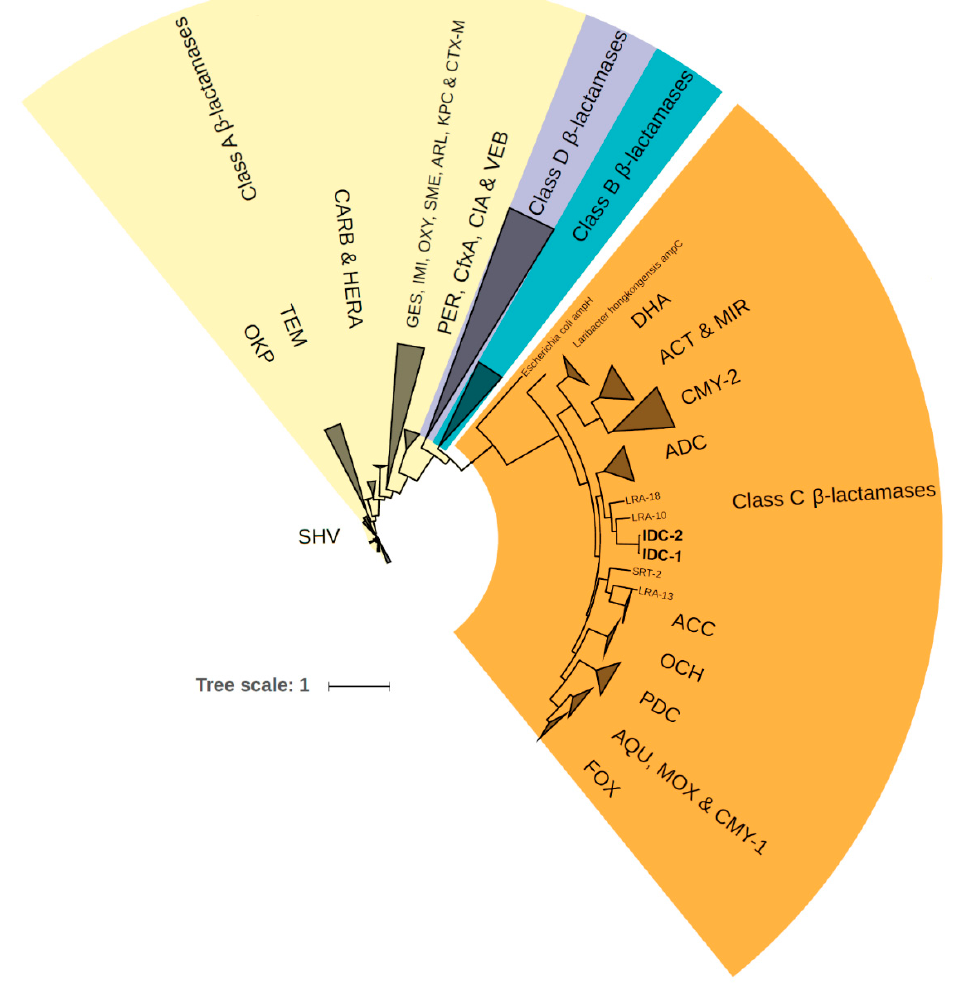
Figure 3. Phylogenetic tree of all four β -lactamase classes and the two newly discovered integron- derived AmpC variants IDC-1 and